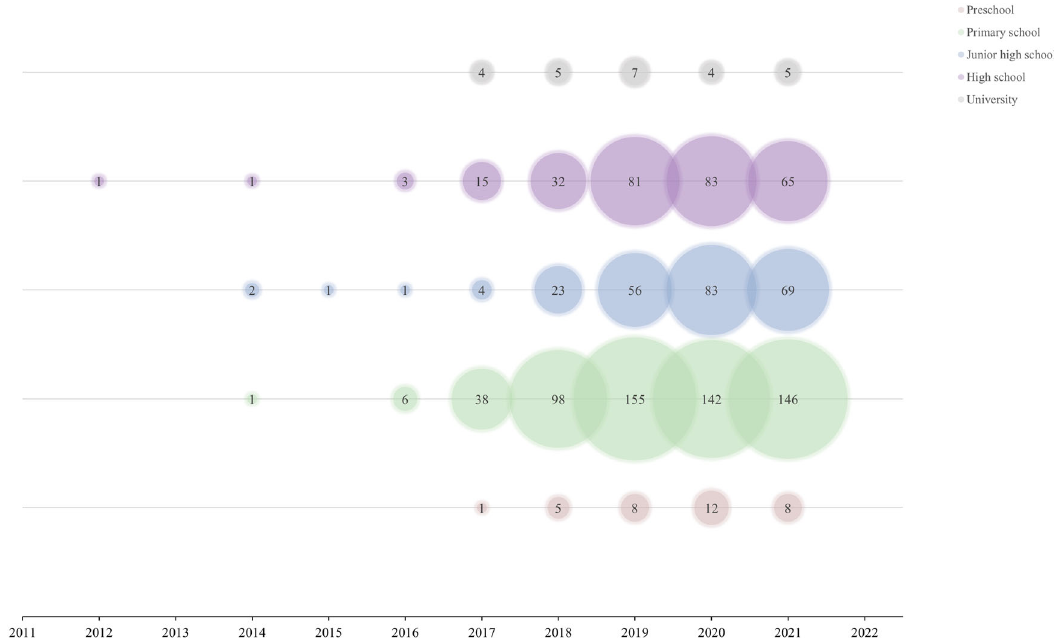
Fig. 1 The number of empirical studies on STEM/STEAM covered in different school stages from 2011 to 2021 (data extracted from CNKI). STEM topics abound in diverse Chinese educational academic conferences and journals covering all school stages. Especially in primary and secondary schools, substantial research and practical exploration have been